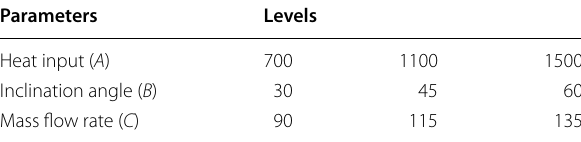
Table 1 Process parameters and their levels